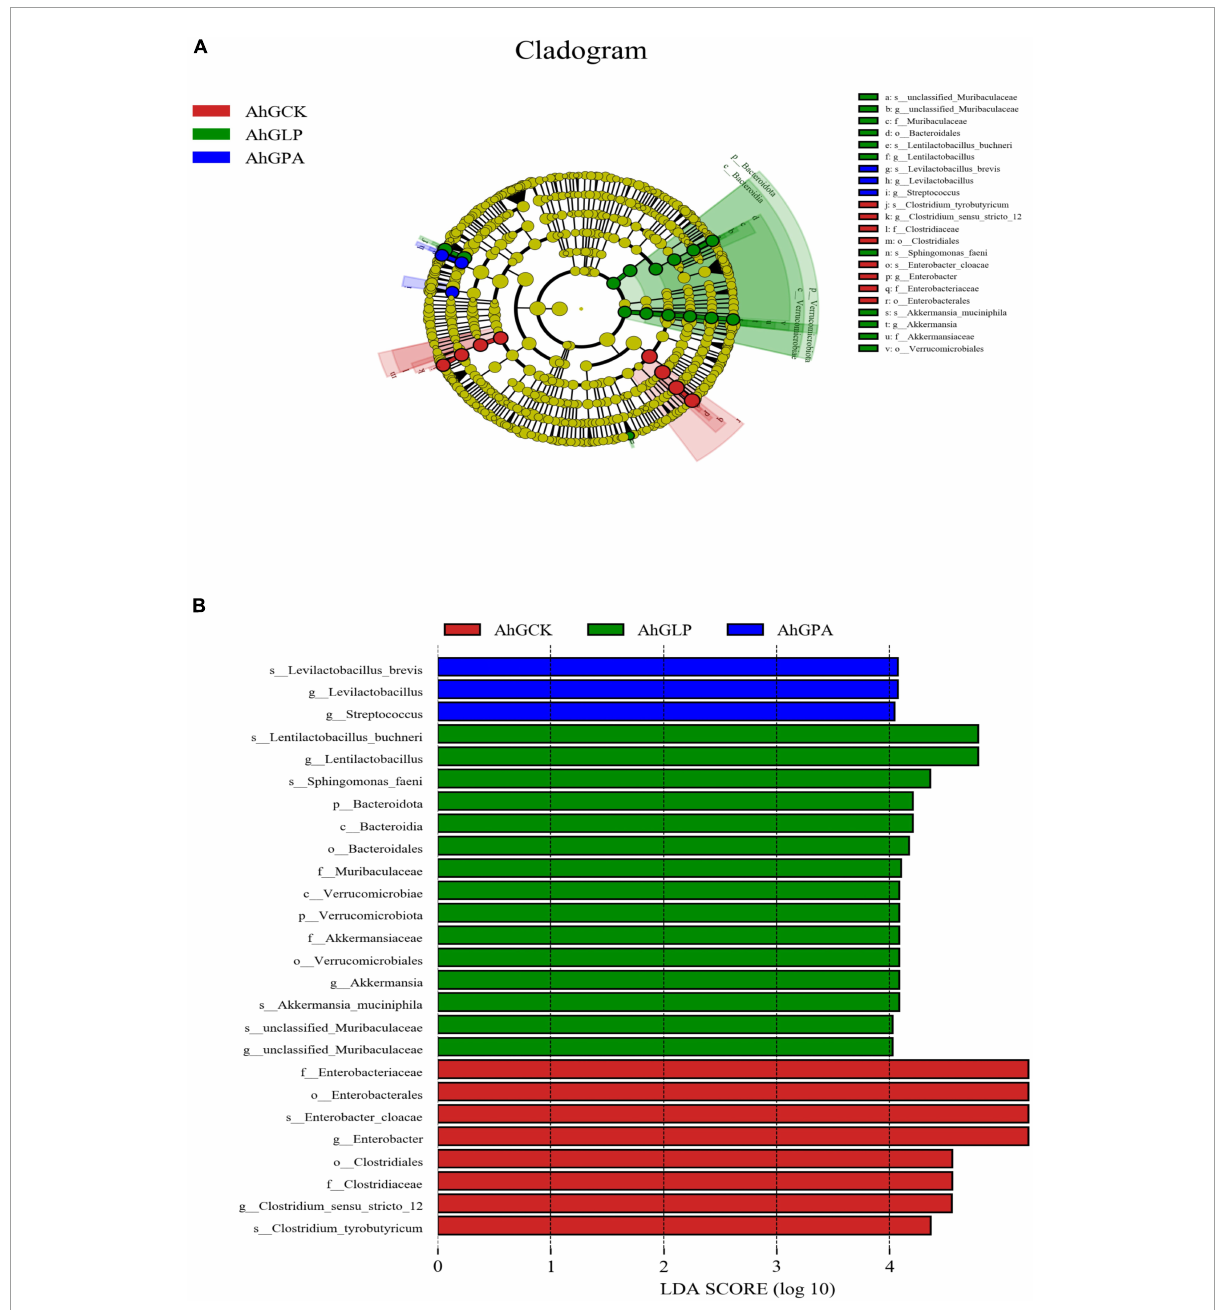
FIGURE3 Comparison of microbial variations using the LEfSe online tool for high-moisture amaranth silage with Lactobacillus plantarum and propionic acid additives. AhGCK, control; AhGLP, L. plantarum ; AhGPA, propionic acid. (A) Cladogram for taxonomic representation of significantly differences. (B) Indicator bacteria with an linear discriminant analysis (LDA) score of 4 or more in the silage bacterial community under different